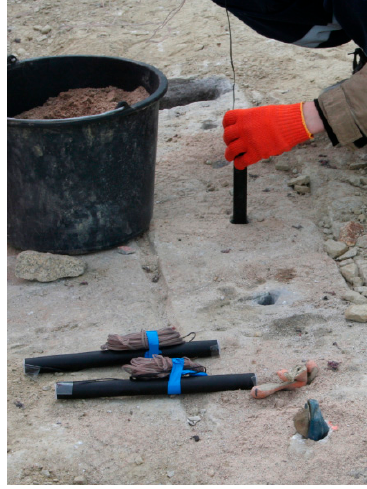
Figure 8. RSP, and the method of its insertion into the blasting hole.